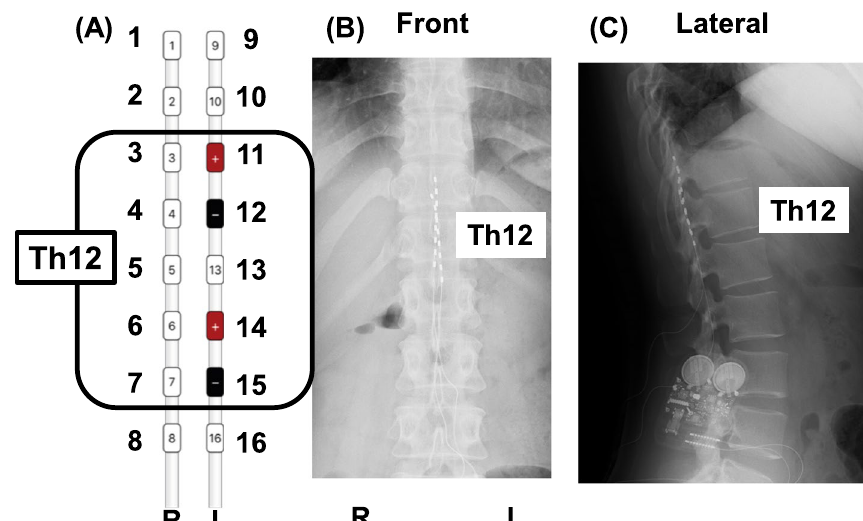
Fig. 1 The two percutaneous trial lead positions. A An enlarged schematic view of the stimulation site. B Plain X-ray front view. C Plain X-ray lateral view. Electrodes number 11, 12, 14, and 15, which correspond to the left-side Th12 level, were used for stimulation. R, right side; L, left side